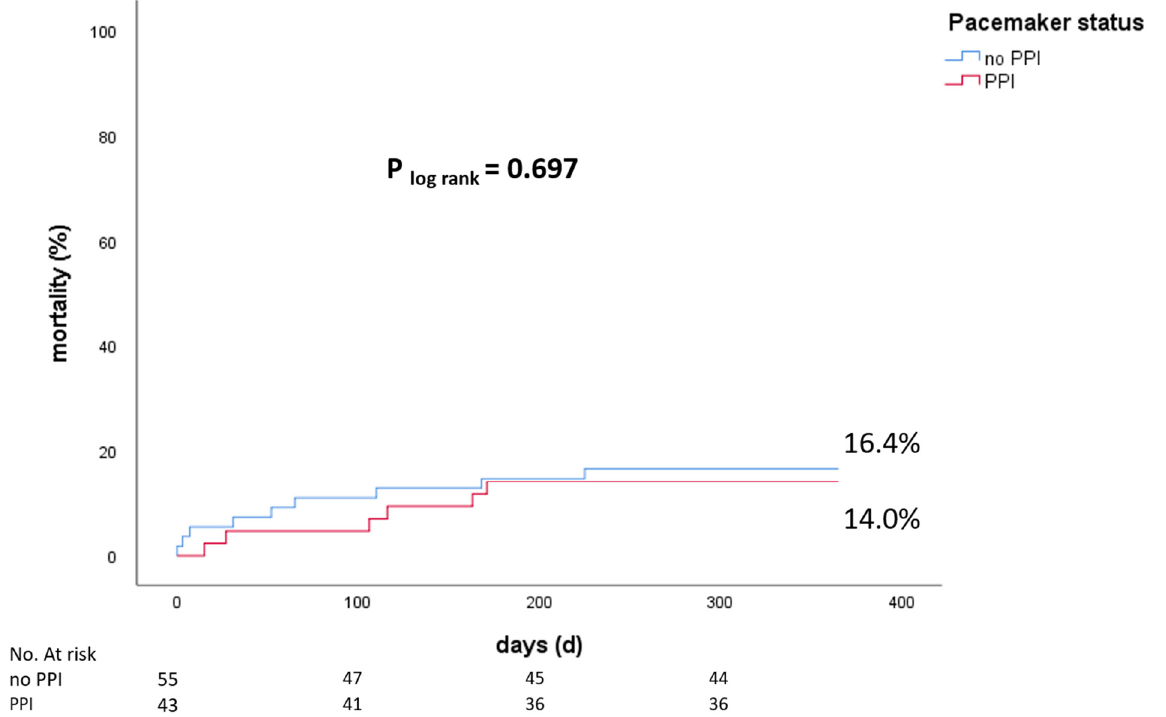
Figure 2. 1-year mortality of patients with PPI and without PPI (PPI = permanent pacemaker Figure 2. 1 ‐ year mortality of patients with PPI and without PPI (PPI = permanent pace ‐ maker implantation).